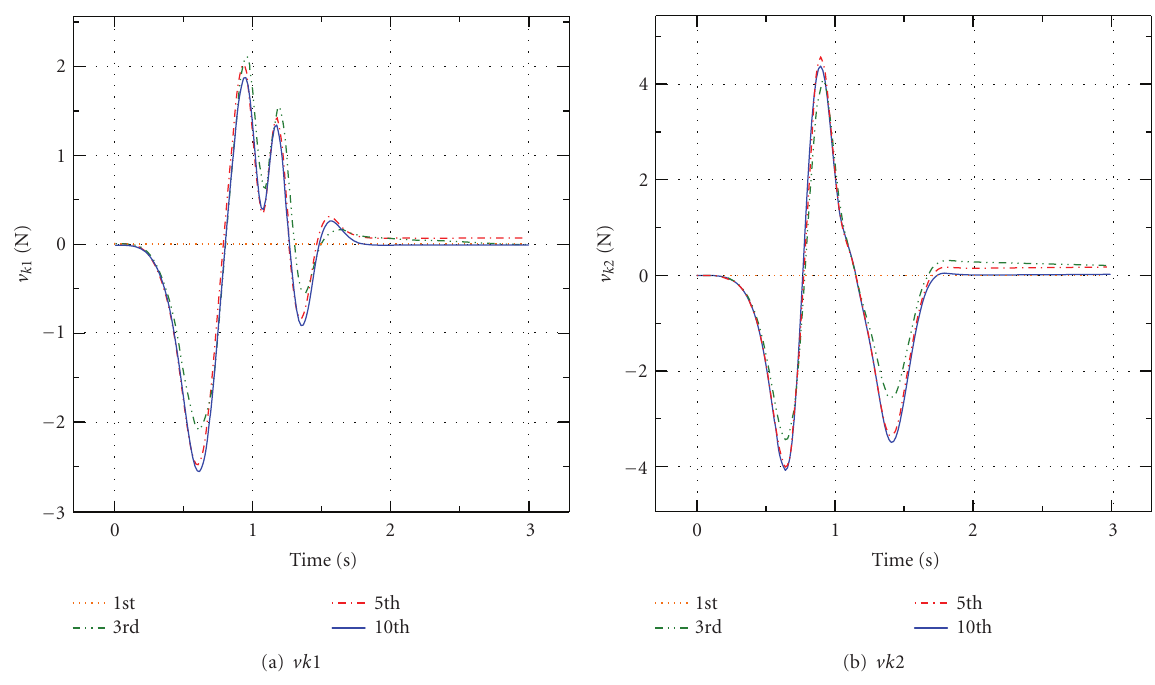
Figure 7: Transient responses of the ILC term v k = ( v k 1 , v k 2 ) T